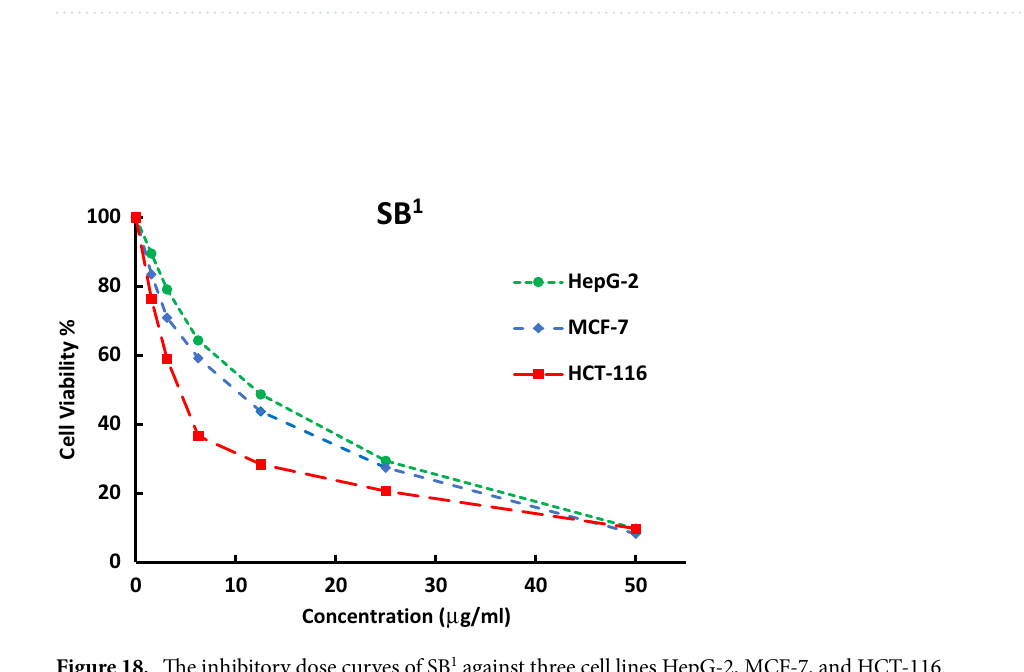
Figure 17. Inhibitory activity of the synthesized ligands against breast carcinoma cells MCF-7.